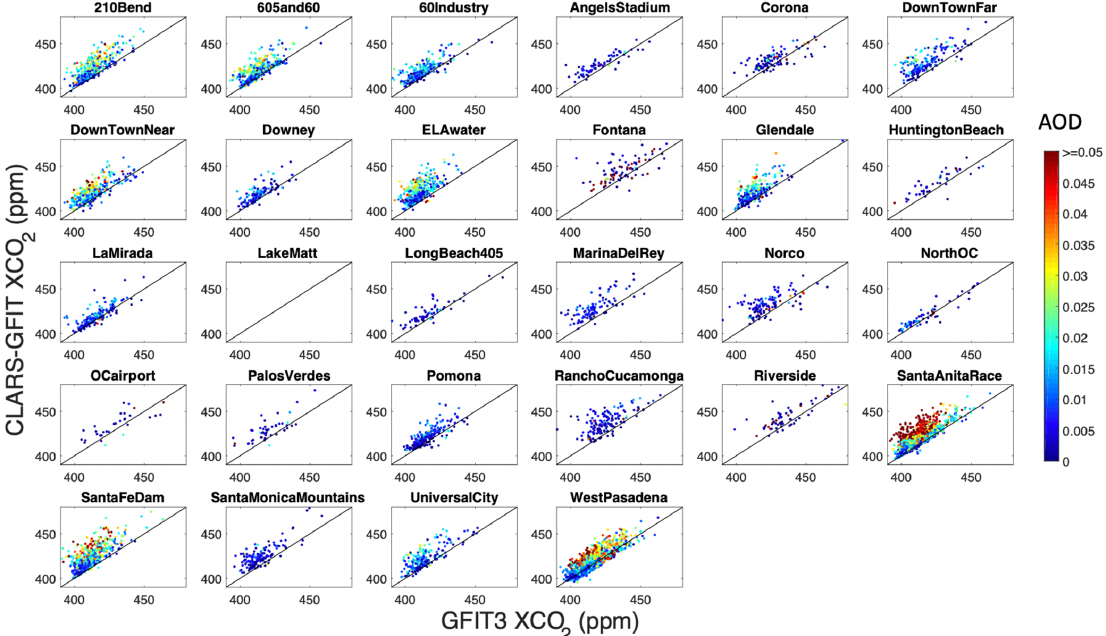
Figure A4. Comparison of XCO 2 retrievals from GFIT3 and CLARS-GFIT for all surface reflection targets. The data points are color-coded by the retrieved AOD.